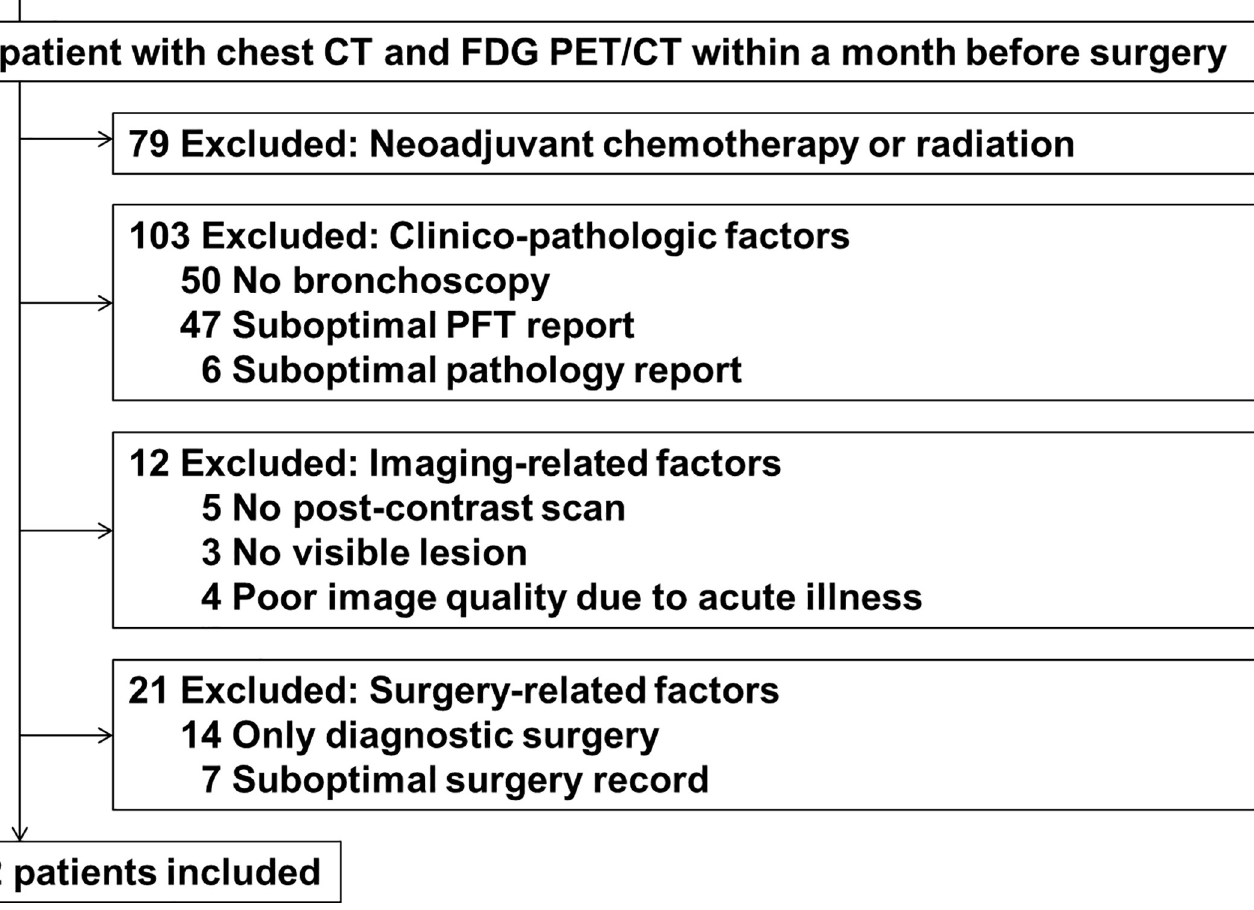
tumor location, necrosis, cavitation, obstructive pneumonitis/atelectasis, pleural effusion, emphysema, interstitial lung abnormalities (ILAs), and “heterogeneity” and “enhancement ratio” of the tumor.